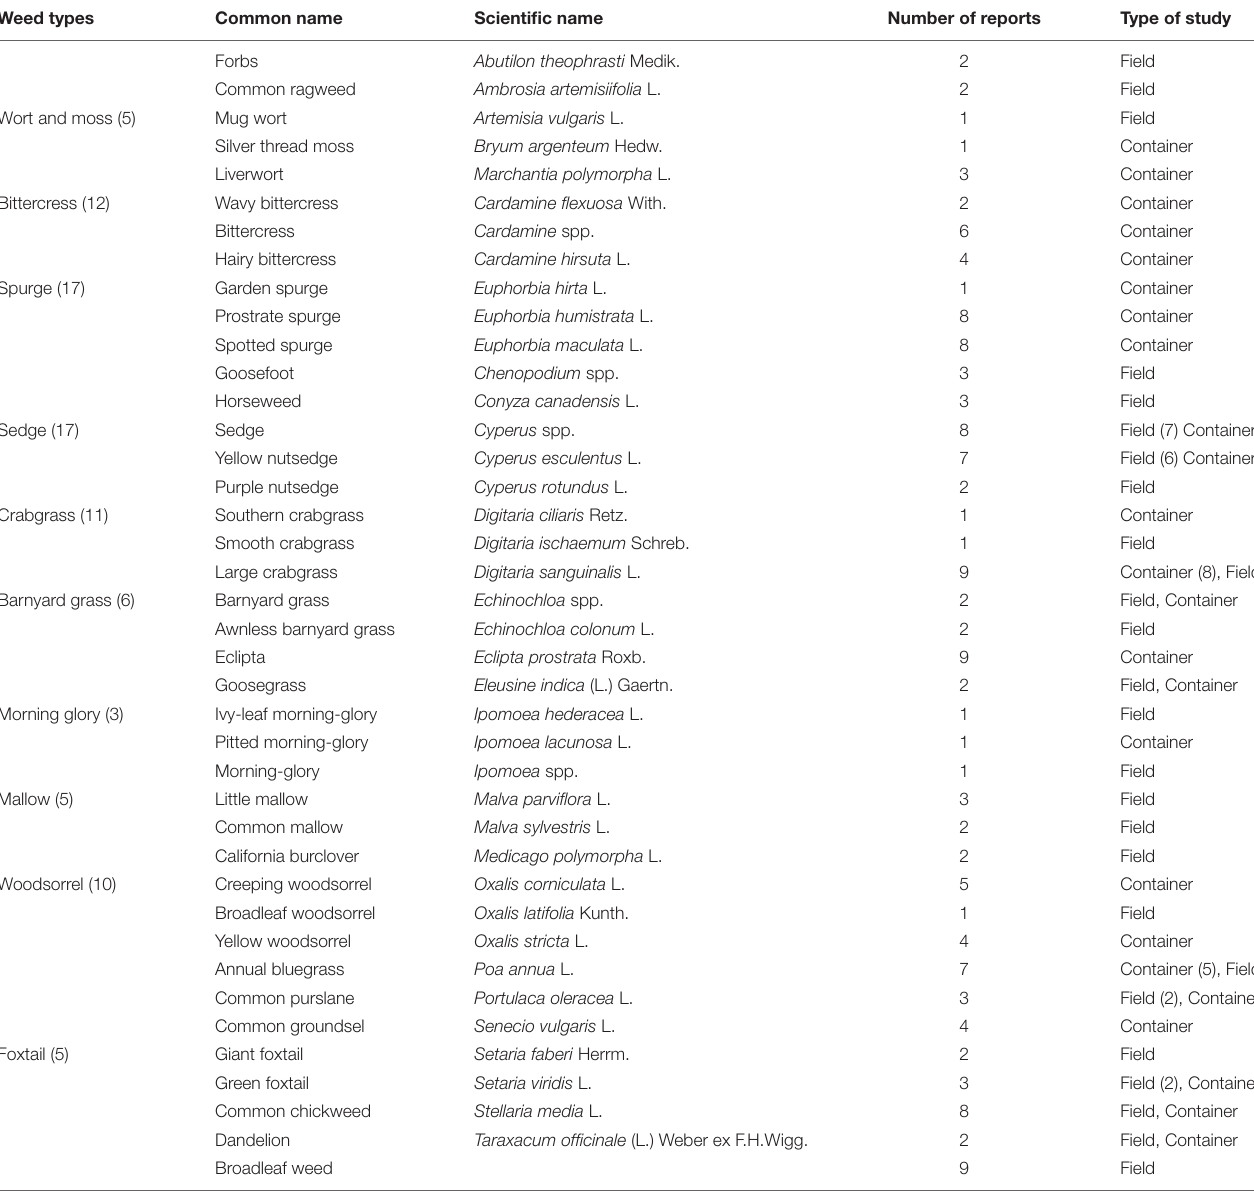
TABLE 1 | Weed species reported in literature (total 114 records) from 1995 to